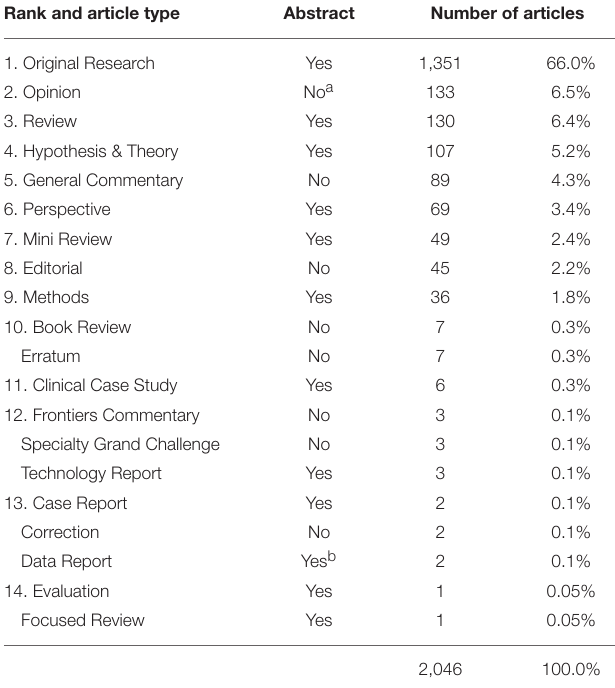
TABLE 1 | Abstract (yes/no) and number of articles ( n and %) of each article